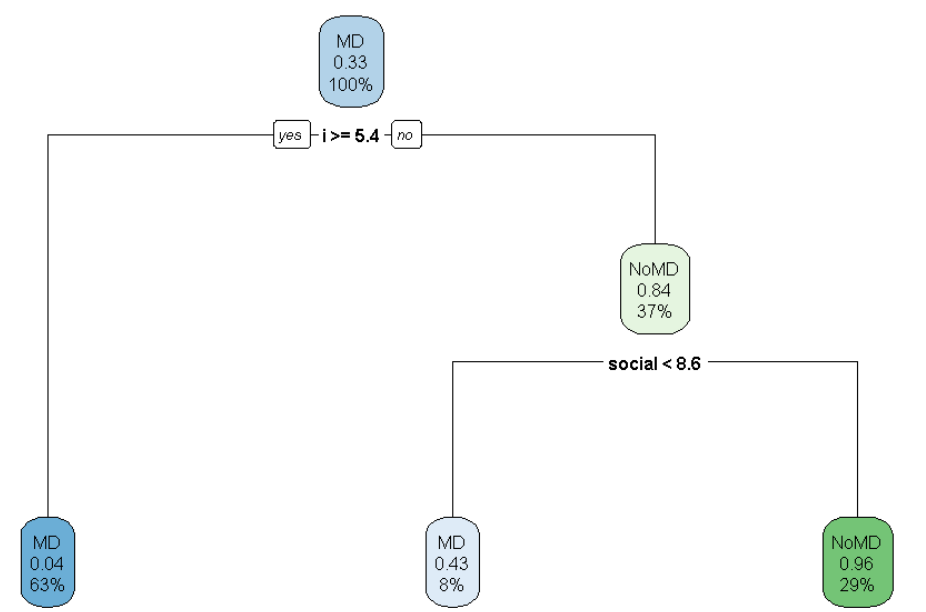
Figure 3. Example decision tree with two LIWC parameters (parameter i means the percentage of first-person pronouns and parameter social the percentage of words referring to others, such as they ; each box lists the choice between mental disorder or not, the chance of the class being no mental disorder and the percentage of the data that fall in this box).